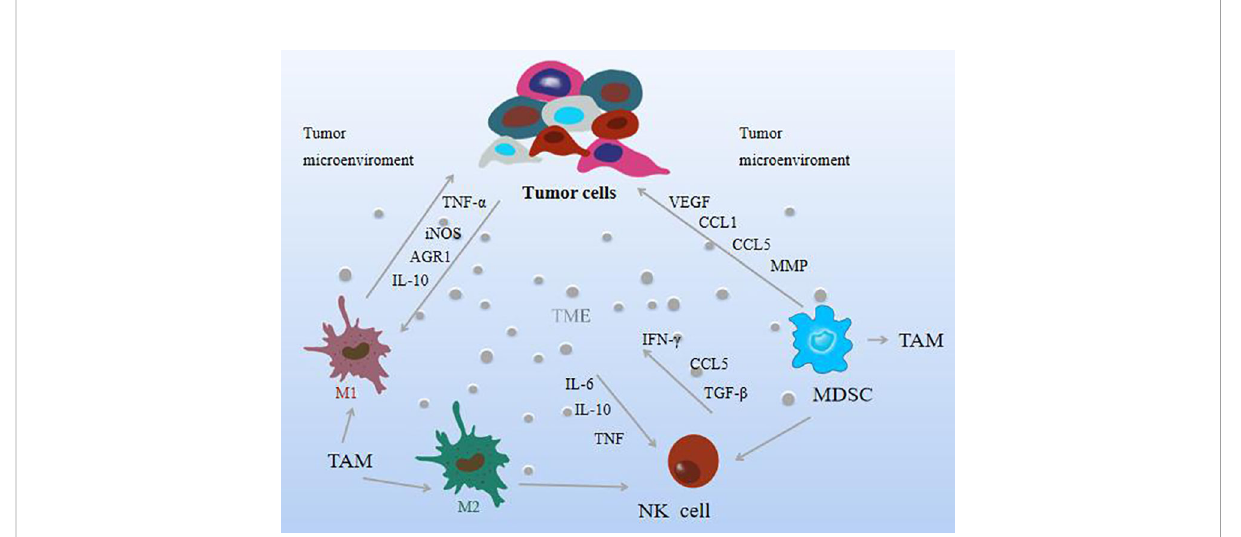
FIGURE 3 The effect mechanism of natural compounds on immune cells in the tumor